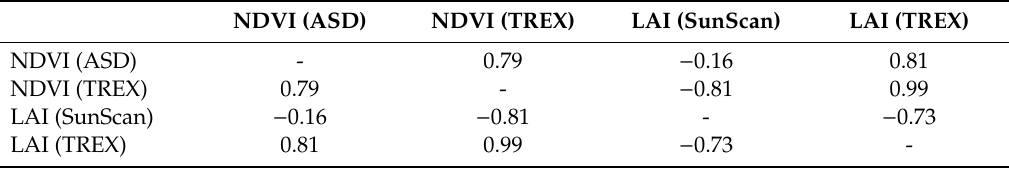
Table 3. Correlation between field measurements (averaged by plot) from 6 July 2017 and maps processed with TREX using five-day synthesized image